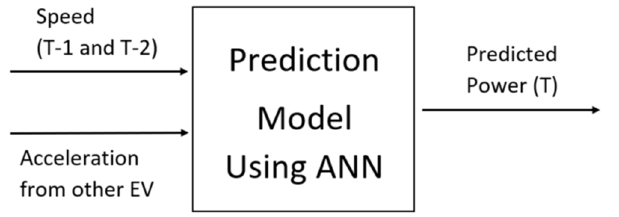
Figure 7. ANN prediction model.